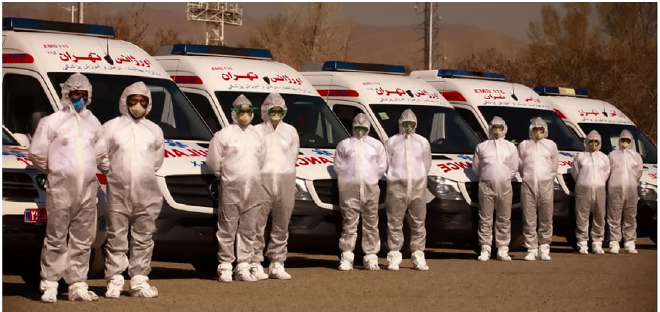
Figure 3. Iranian emergency medical services personnel during the COVID-19